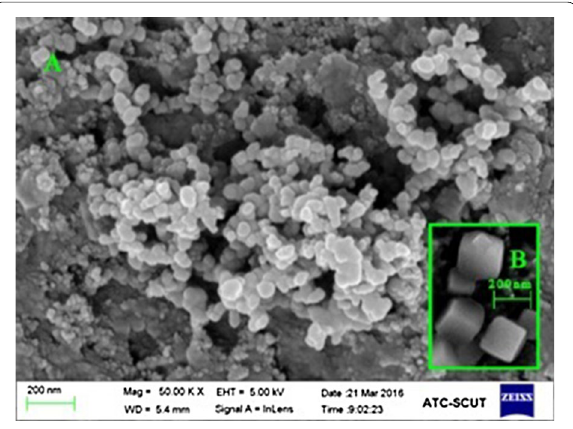
Fig. 3 SEM graphy of Cellu@Fe 3 O 4 ( A ), ZIF‑8@Cellu@Fe 3 O 4 ( B )